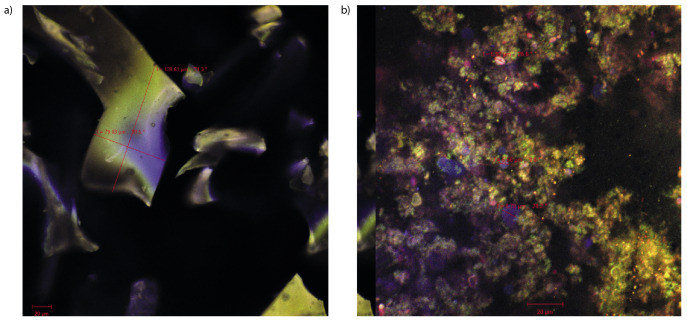
Confocal laser scanning microscopy images of the microencapsulated grape juice powder obtained with a 40× objective: a) native and b) fluorochrome-stained complex